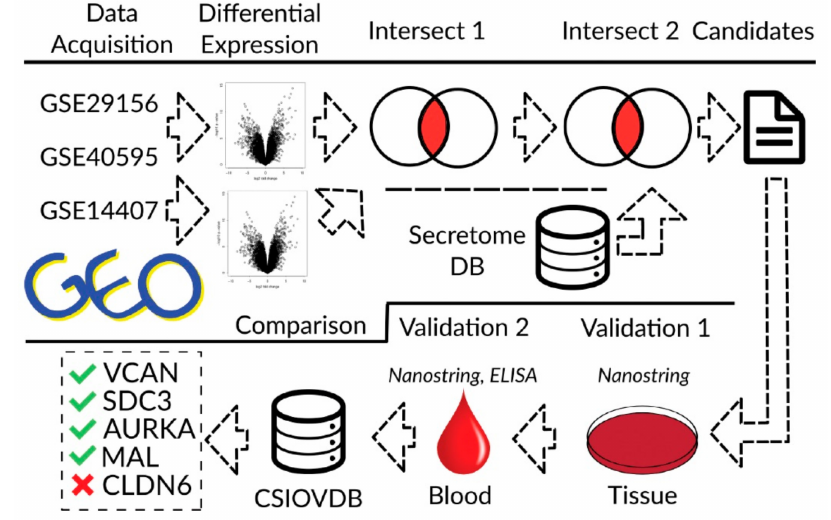
Figure 1. Overview of the biomarker identification concept. Three independent studies for genes over-expressedinmalignanttissuewereinterrogated(GeneExpressionOmnibus(GEO)seriesGSE29156, GSE40595 and GSE14407). Genes found to be over-expressed in both studies while simultaneously being secreted into the bloodstream were defined as biomarker candidates using the secretome database